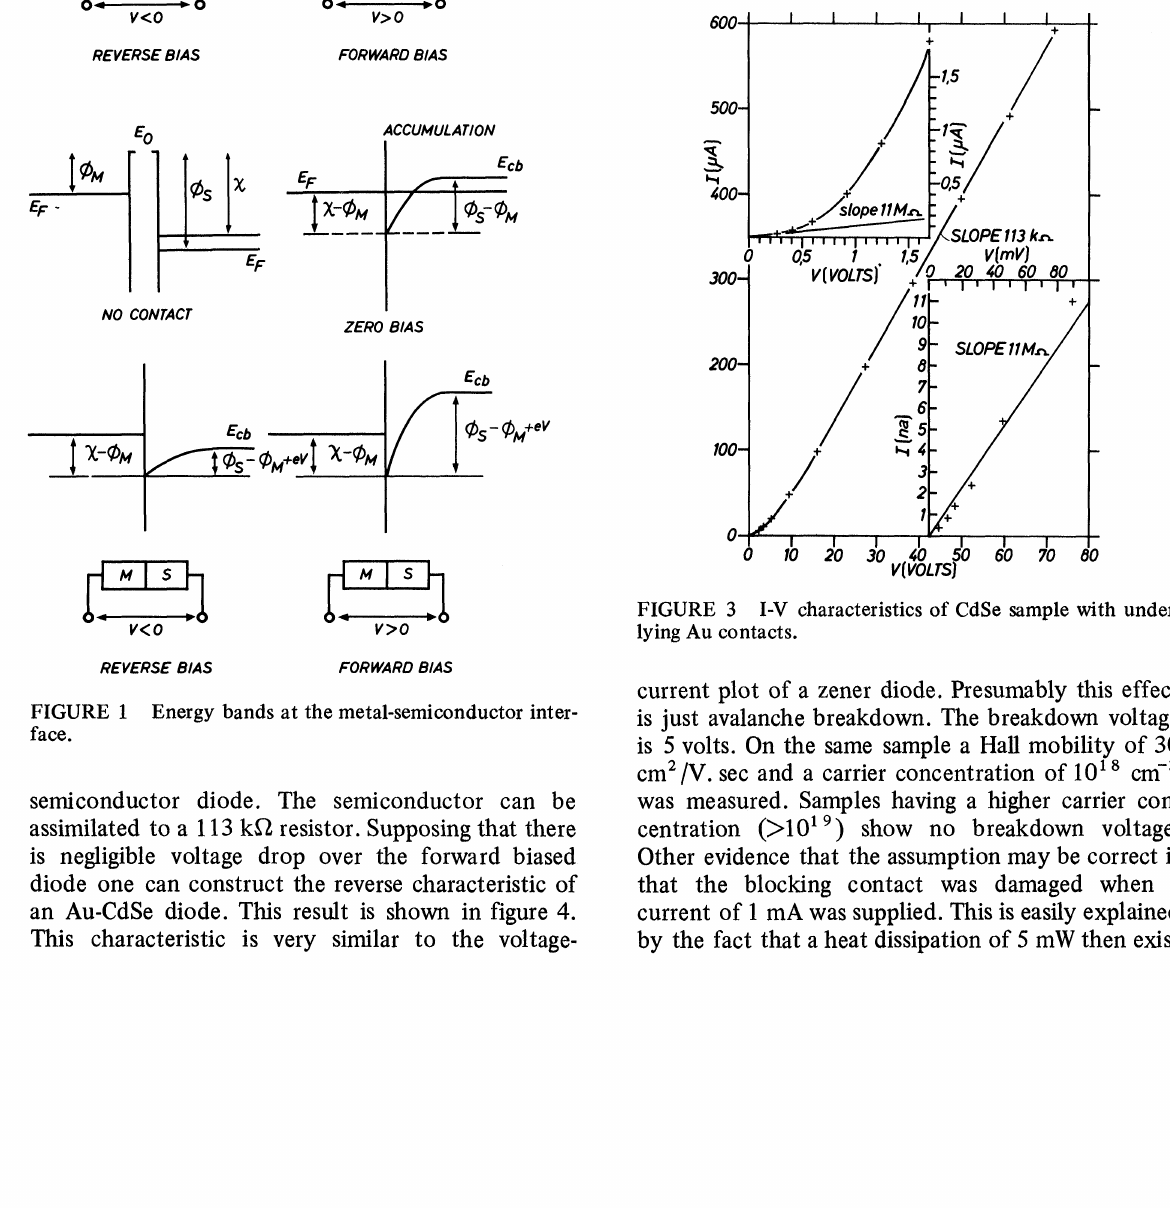
FIGURE 2 Cross shaped sample geometry.